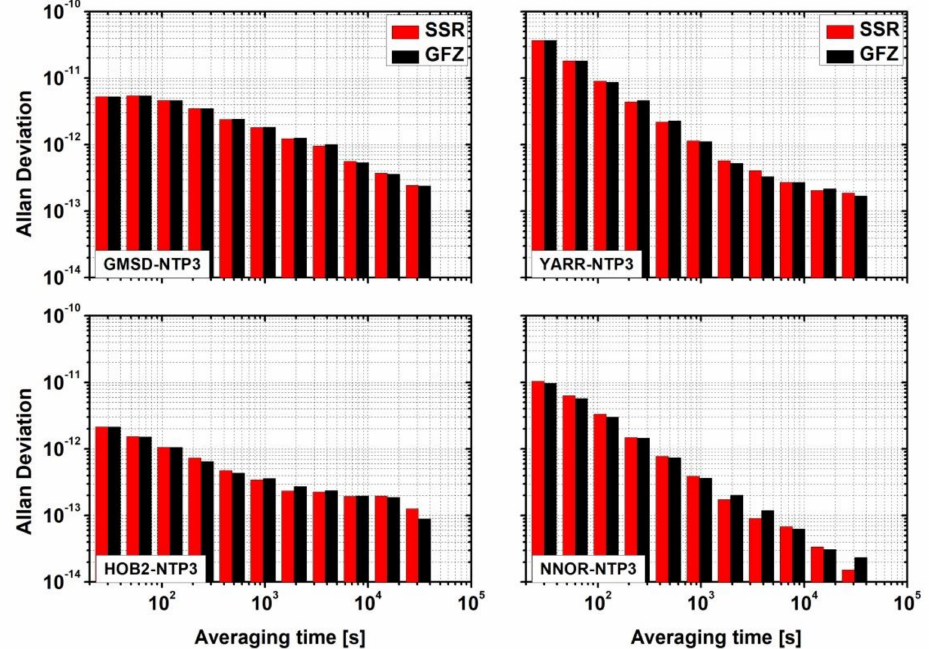
Figure 10. GLONASS Allan deviation (ADEV) for SSR and GFZ solutions.